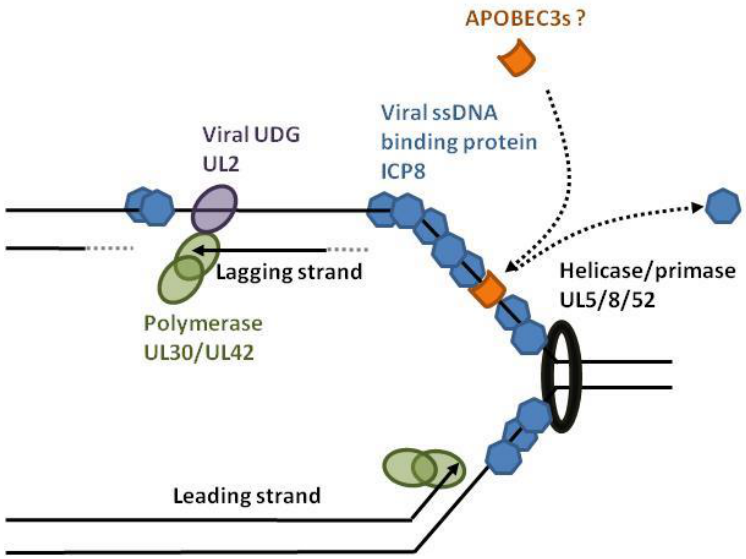
Figure 6. HSV-1 replication fork and hypothetical model of APOBEC3 editing. In the nucleus, replication of HSV-1 is initiated by the origin binding protein (UL9) that melts double-stranded DNA. The helicase/primase complex (UL5/UL8/UL52) unwinds and anneals RNA primers, allowing DNA replication by the UL30/UL42 complex. The viral protein ICP8 covers the transiently exposed single-stranded DNA and competes with the APOBEC3 binding. The viral UL2 is a uracil-DNA glycosylase (UDG) that favors replication-coupled base excision DNA repair.